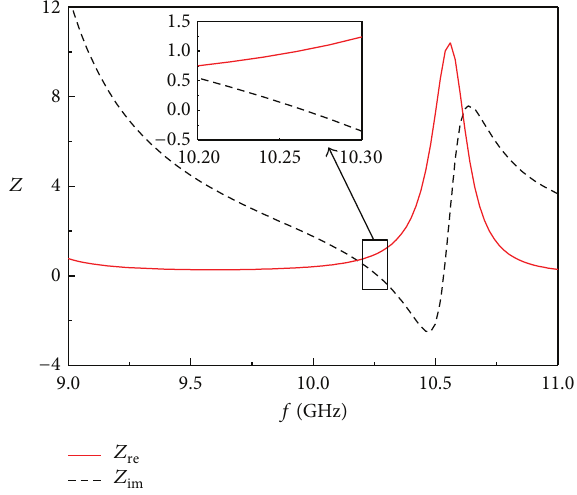
Figure 3: Calculated real and imaginary part of the effective impedance of the proposed MA.